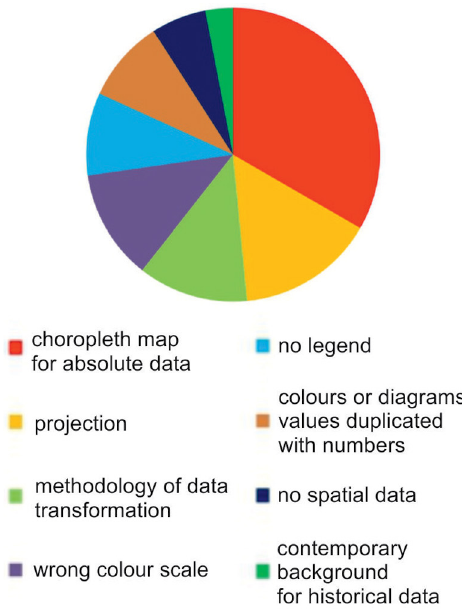
Fig. 4. The distribution of typical errors on the maps